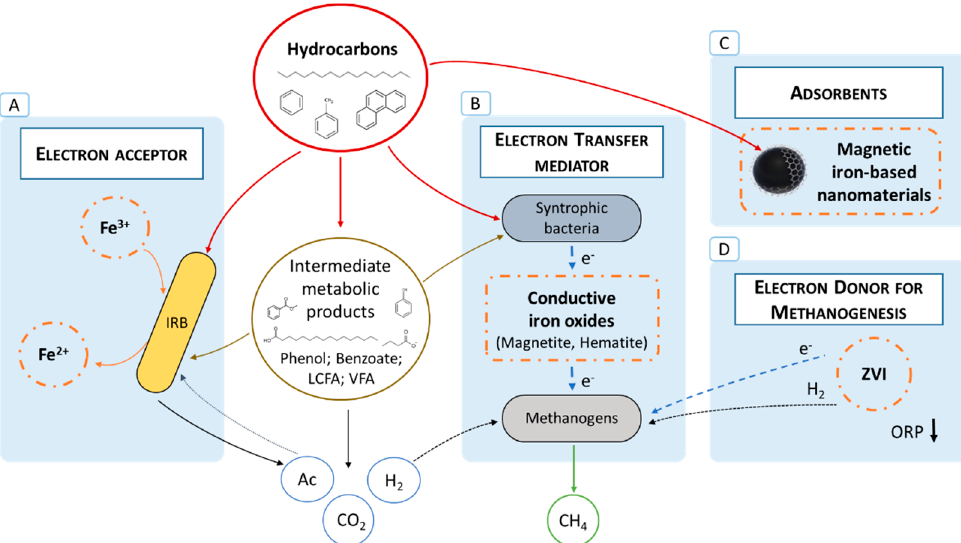
Figure 1. Scheme of the potential roles of different iron compounds in anaerobic degradation of petroleum hydrocarbons: Fe(III) as electron acceptor ( A ); conductive iron oxides as electron transfer mediators in hydrocarbon conversion to methane ( B ); magnetic iron compounds as hydrocarbon adsorbents ( C ); and zero-valent iron (ZVI) as electron donor for methanogenesis ( D ). IRB—iron- reducing bacteria; LCFA—long chain fatty acids; VFA—volatile fatty acids; Ac—acetate; ORP— oxidation-reduction